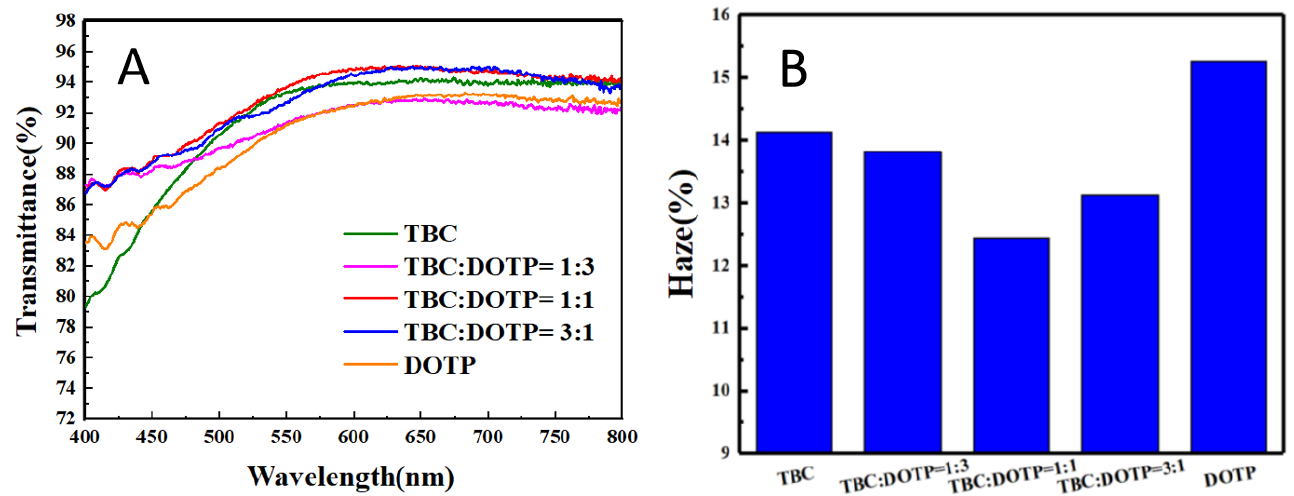
Figure 11. The transmittance ( A ) and haze ( B ) of PVC with Zn(Arg) 2 plasticized by TBC and DOTP in different proportions.